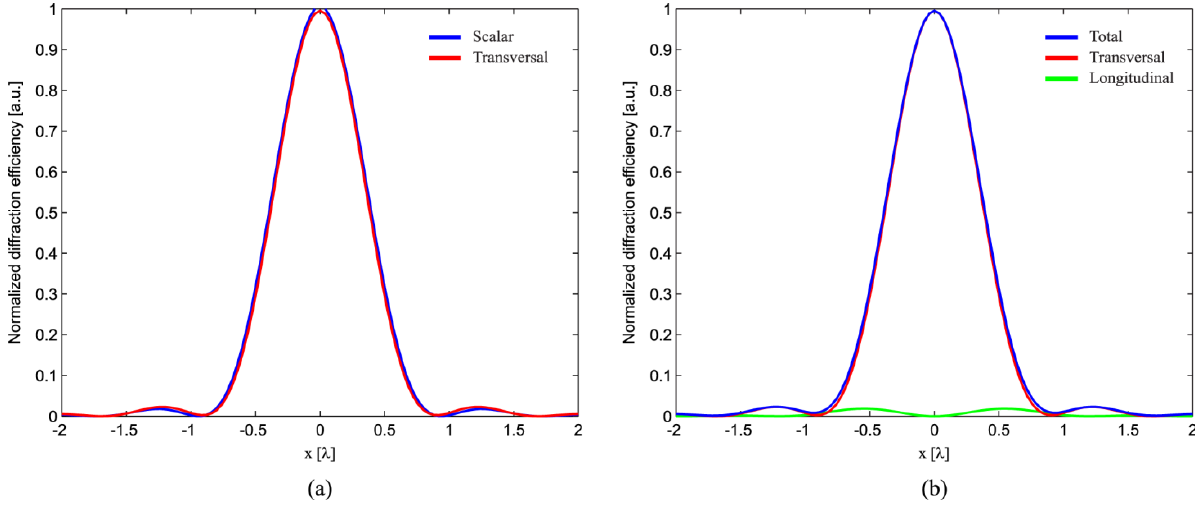
Figure 5. Comparison of the full width at half maximum (FWHM) in the photopolymer for scalar and vector diffraction theory: ( a ) scalar and transversal component in vector diffraction theory and ( b ) the total, transversal, and longitudinal component in vector diffraction